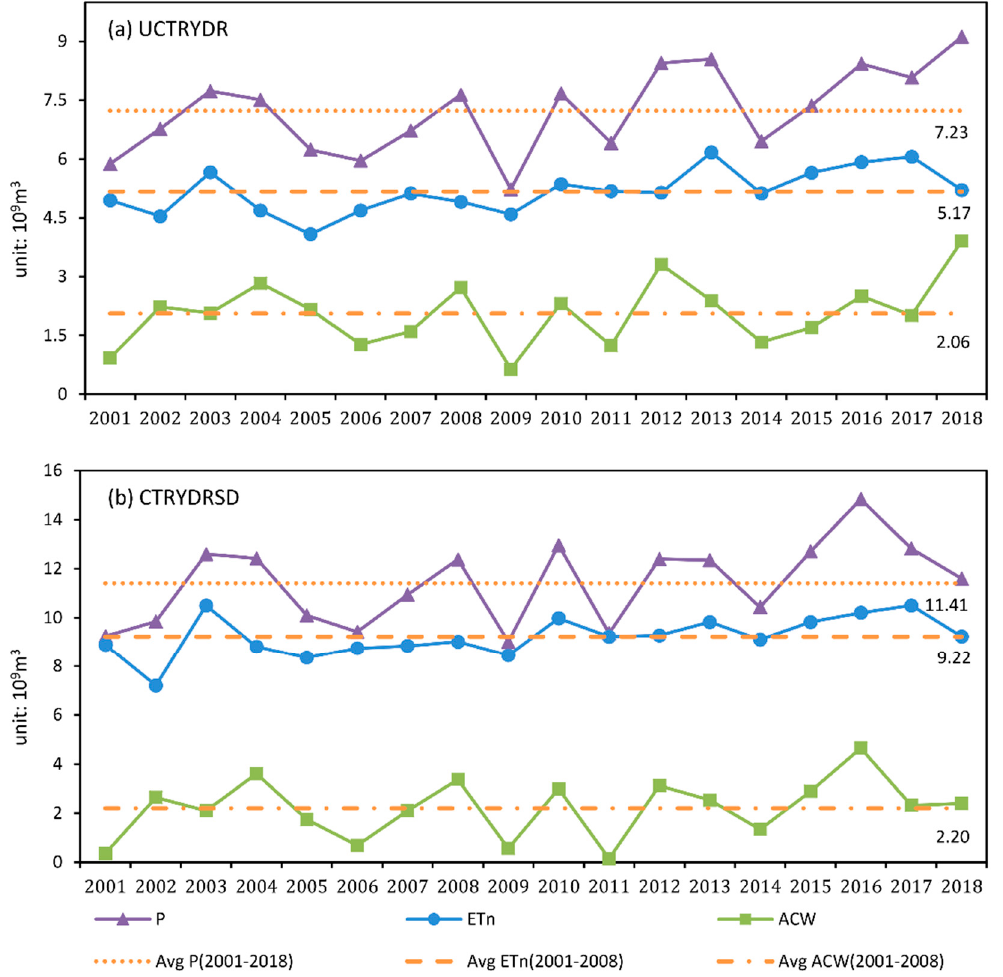
Figure 3. Precipitation, natural ET and ACW development in ( a ) the UCTRYDR; and ( b ) the CTRYDRSD from 2001 to 2018.